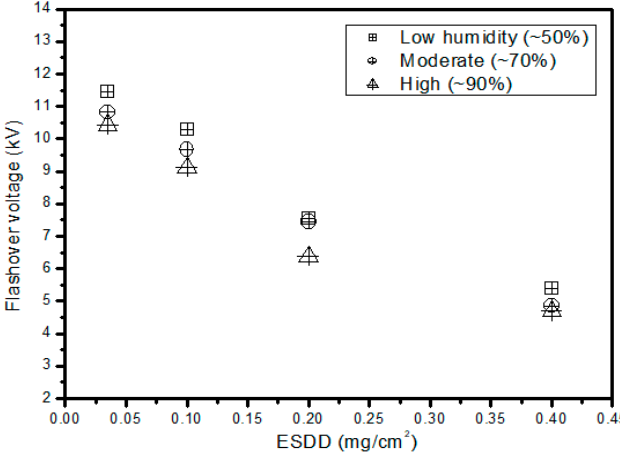
Figure 4. The relationship between relative humidity and critical flashover voltage at 10 °C temperature and NSDD of 0.75 mg/cm 2 .